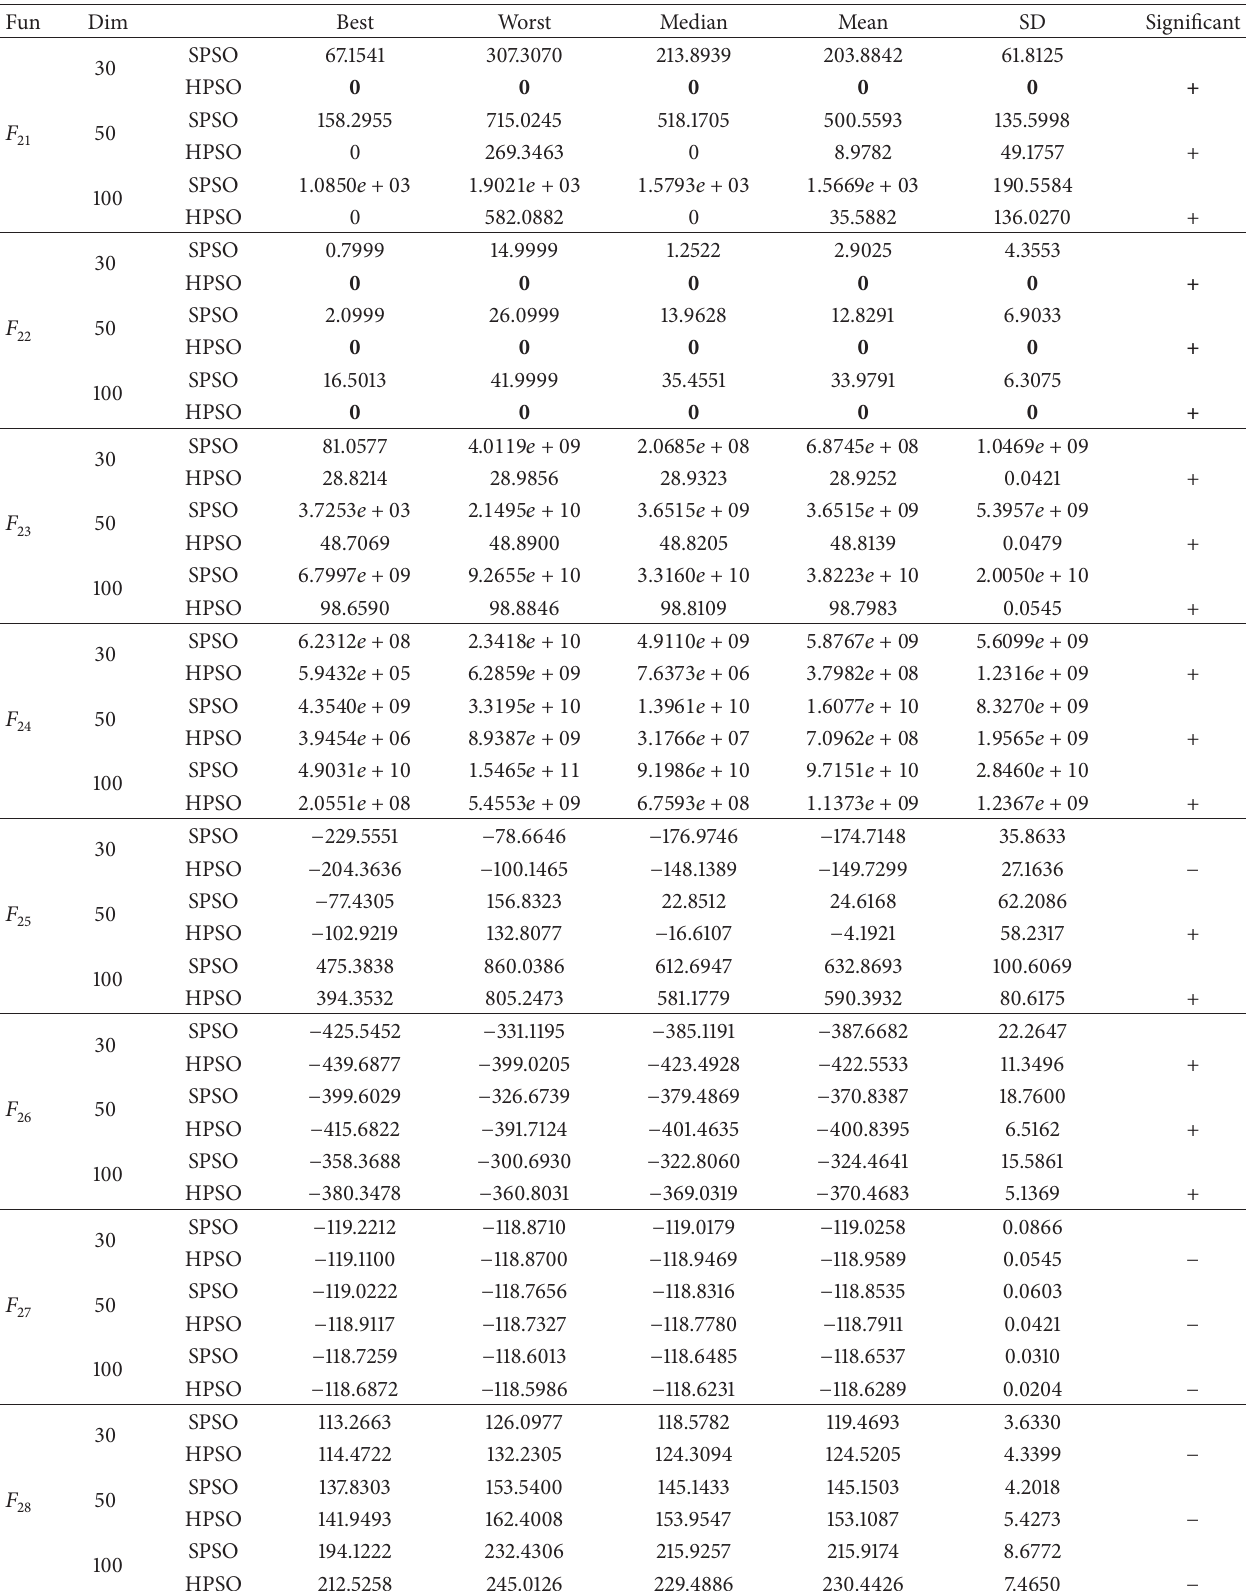
Table 4: Experimental results obtained by SPSO and HPSO on functions from 𝐹 21 to 𝐹 28